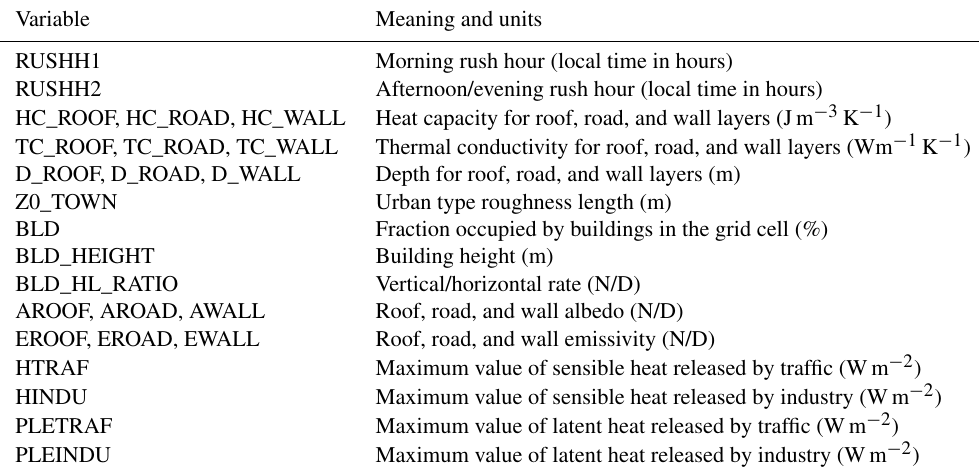
Table 3. List of parameters that can be modified by the user when using TEB in the model.